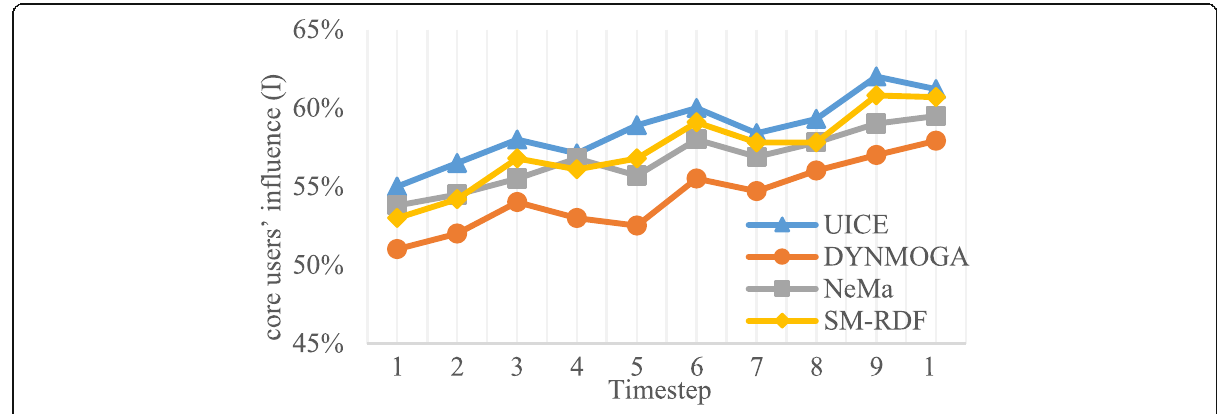
Fig. 8 Core users ’ influence ( I ) value comparison